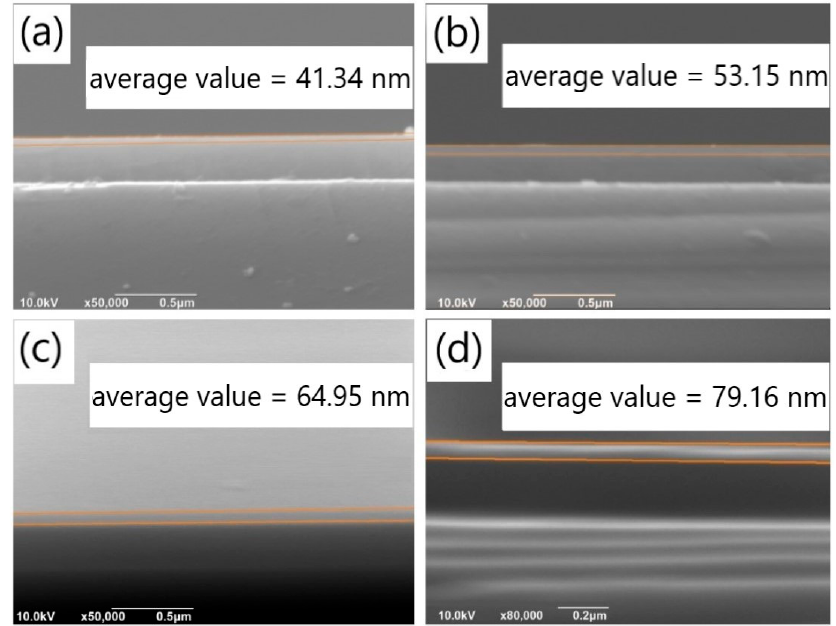
Figure 5. Cross-sectional SEM images of PDA films obtained on silicon dioxide substrates under the concentration conditions of ( a ) 1.5 mg/mL and ( b ) 2 mg/mL with a deposition time of 60 min; Cross-sectional SEM images of the PDA film obtained on the silicon dioxide substrates under the concentration conditions of ( c ) 1.5 mg/mL and ( d ) 2 mg/mL with a deposition time of 90 min.